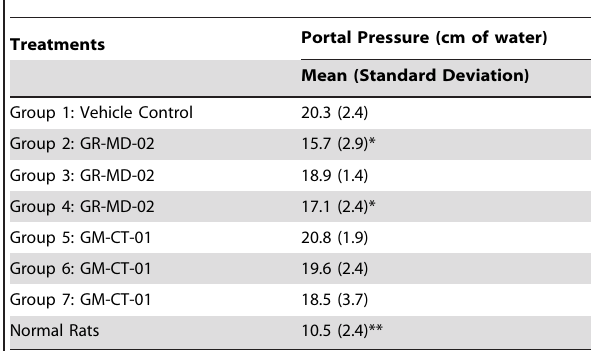
Table 1. Portal pressures in rats at